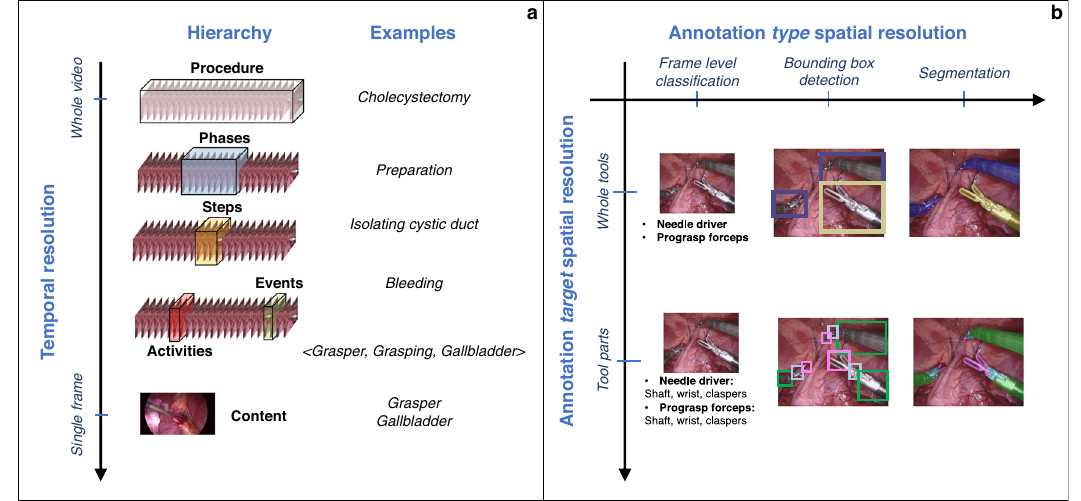
Fig. 1 Framework for the analysis of endoscopic videos. Temporal ( a ) and spatial ( b ) annotations at different resolutions are used to model tasks at increasingly fi ner